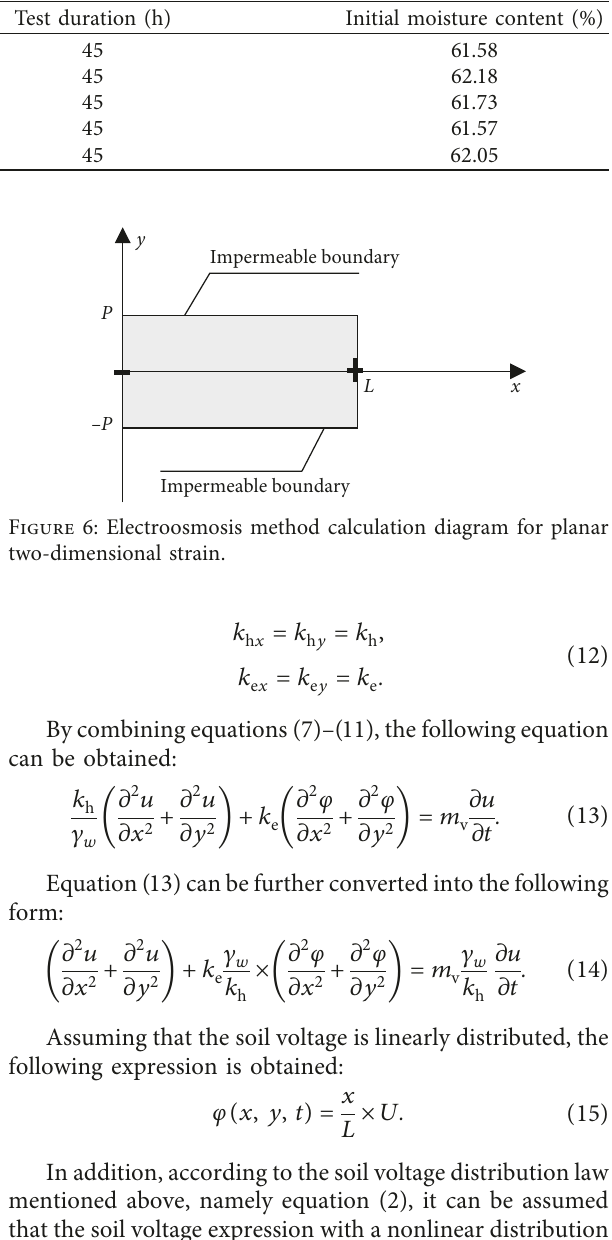
Table 2: Summary of the test parameters.